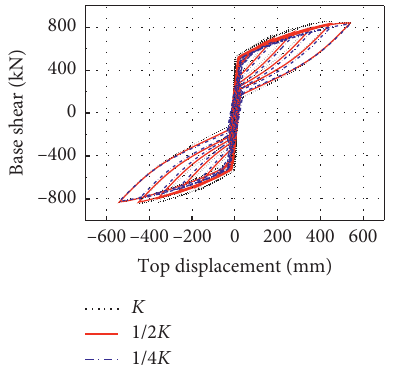
Figure 24: Hysteresis loop of the base shear versus top displacement.